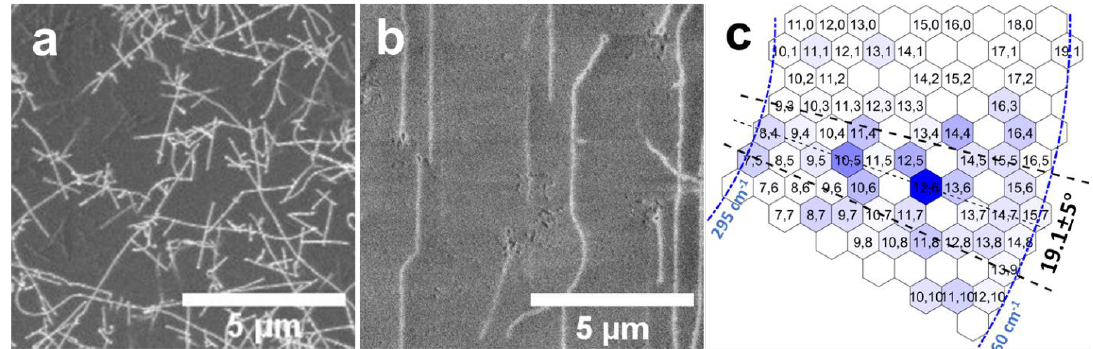
Figure 3. Carbon nanotubes (CNTs) grown from W-Co alloy nano-catalysts. ( a ) Random and ( b ) aligned CNT array grown on SiO 2 / Si and ST-cut quartz substrates without any ex situ transfer processes. ( c ) Chirality enrichment is measured by Raman RBM with 532, 638, and 785 nm lasers on random CNTs arrays grown on the SiO 2 / Si substrate. The peak position abundance statistics results from three lasers are summarized with a normalized scale. After converting peak position abundance to chirality abundance based on the Kataura plot, the results are displayed on a map. To guarantee unambiguous identification, the painting is done only for single-walled CNTs (SWCNTs) with 0.81 nm < diameter < 1.53 nm (160–295 cm − 1 , marked by the blue dash-dotted line). Chirality cells that are not resonant with three lasers are left empty. Chiralities near ( 2n,n ) most enriched (corresponding range of 19.1 ± 5 ◦ ) are marked by a black dashed line, and few can be found near the zigzag region.